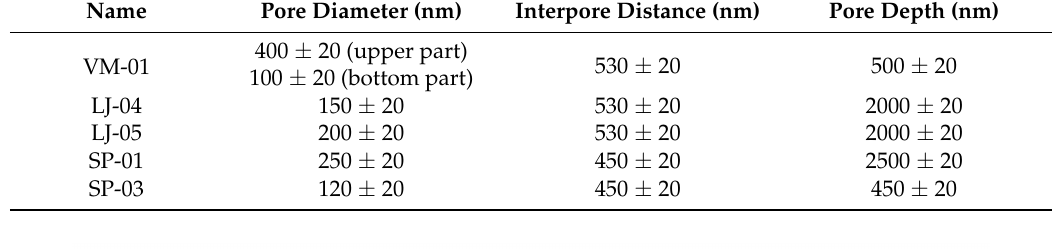
Table 1. Dimensions of the AAO molds employed in this study.